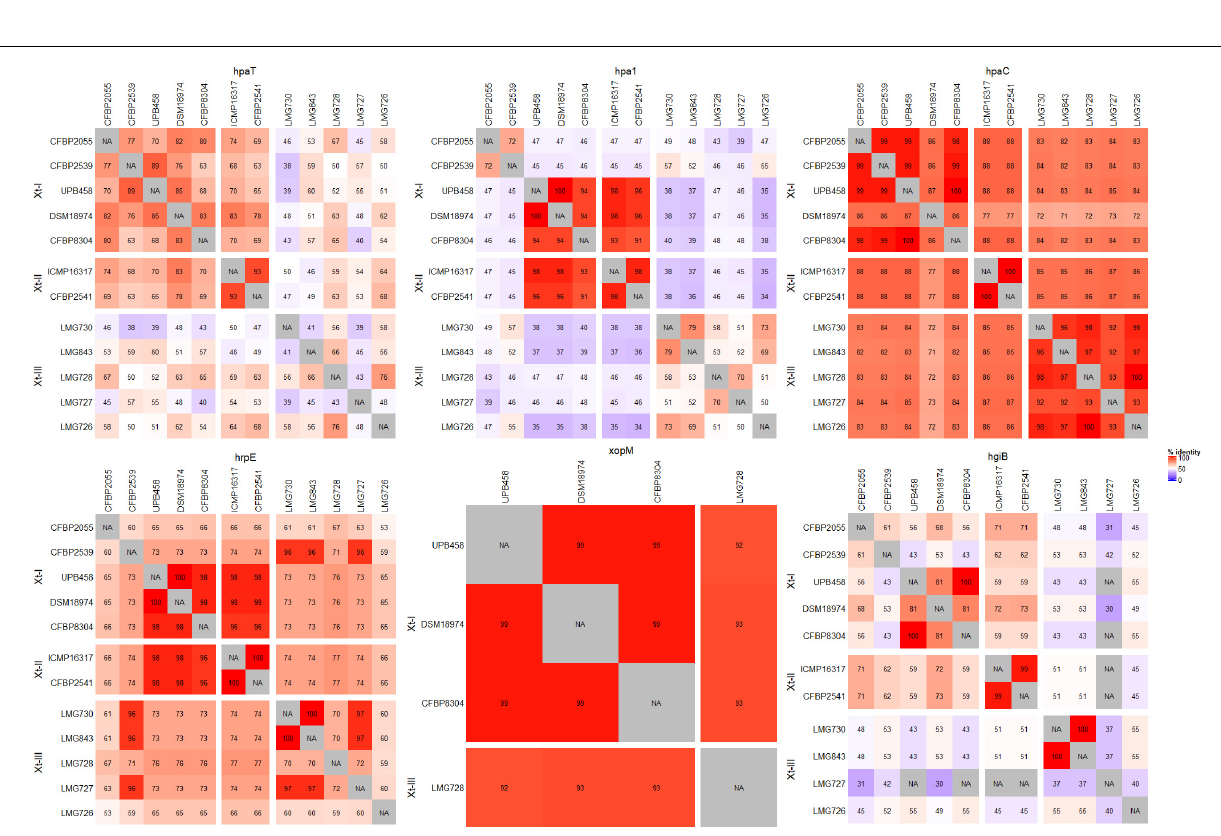
Frontiers in Microbiology |